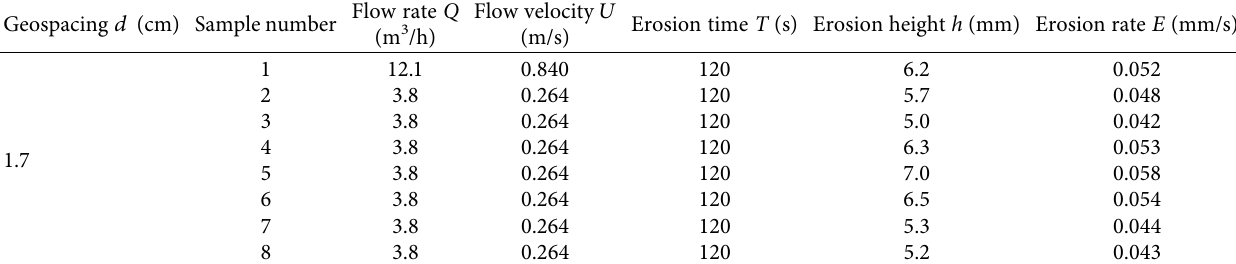
Table 3: Experimental data of tailings erosion with the reinforcement spacing of 1.7cm.